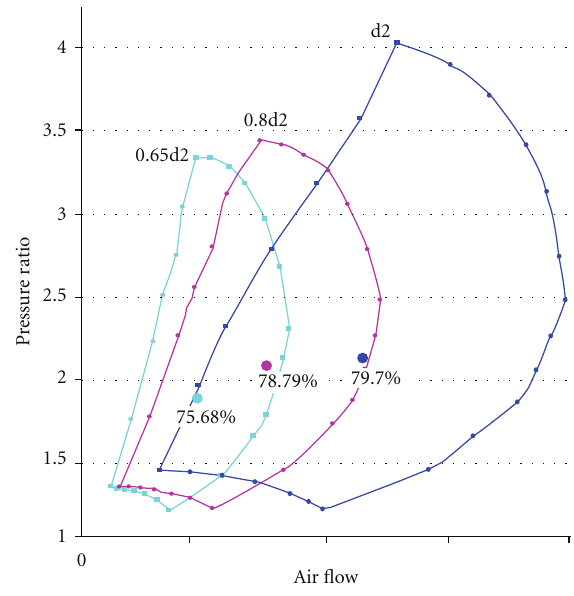
Figure 23: Performance characteristics of an impeller diameter